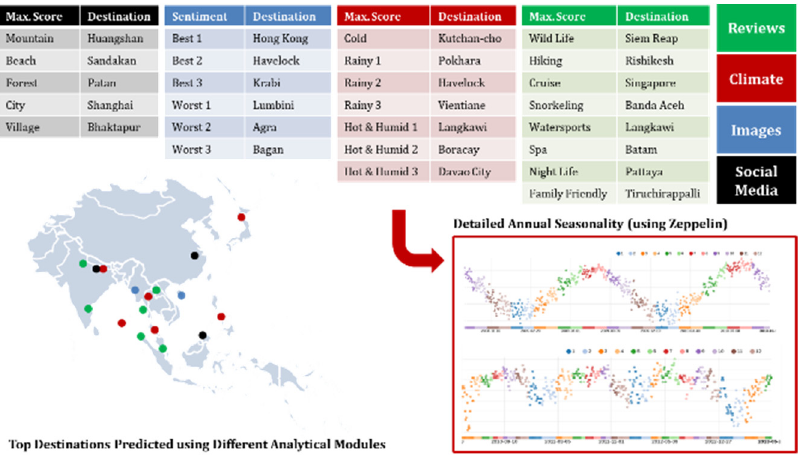
Figure 23. User input and thematic TRS output.